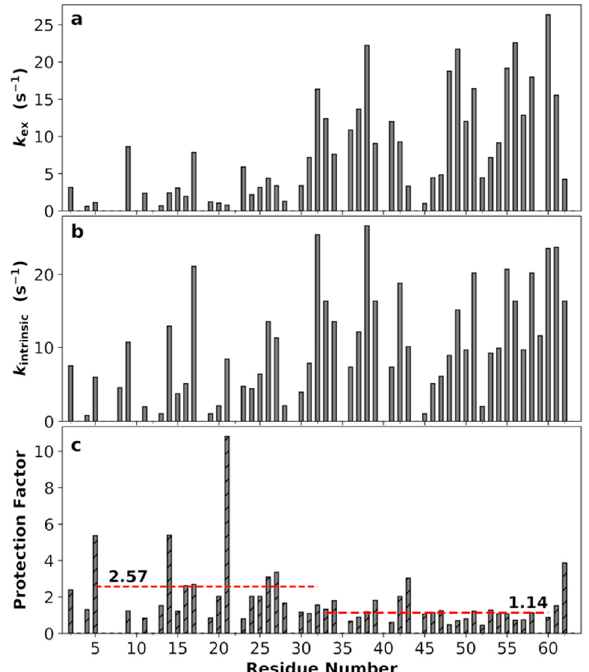
Figure 8. Backbone amide proton exchange rates ( k ex ; pH 7.0), intrinsic exchange rates ( k intrinsic ), and protection factors. ( a ) k ex , ( b ) k intrinsic , ( c ) protection factors. The mean protection factors for residues 5–32 and 33–60 are shown by red dashes.